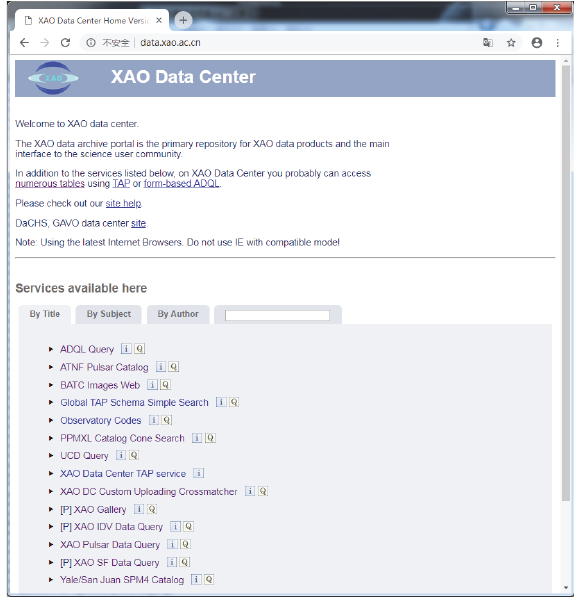
Figure 2: The main page of XAO data archive